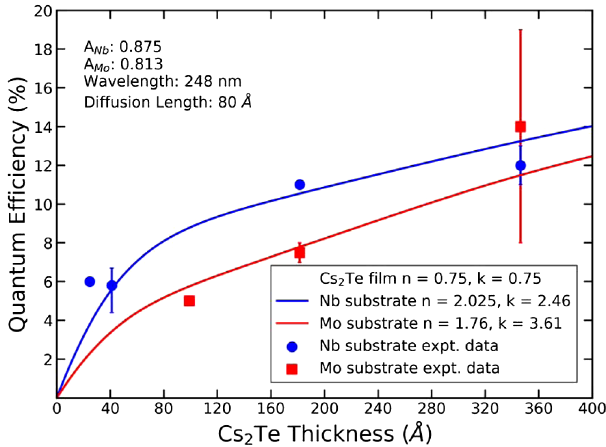
FIG. 2. Dependence of the quantum efficiency (QE) of Cs 2 Te films on Nb (blue circles) and Mo (red squares) substrates vs estimated Cs 2 Te thickness. Cs 2 Te thickness is estimated to be 1.65 times the Te thickness. Data points correspond to the average values while error bars represent the maximum and minimum measured QE for multiple samples of any given thickness. Solid curves are the phenomenological model fits described in the text using n and k , the real and imaginary parts of the index of refraction, respectively, for the film and